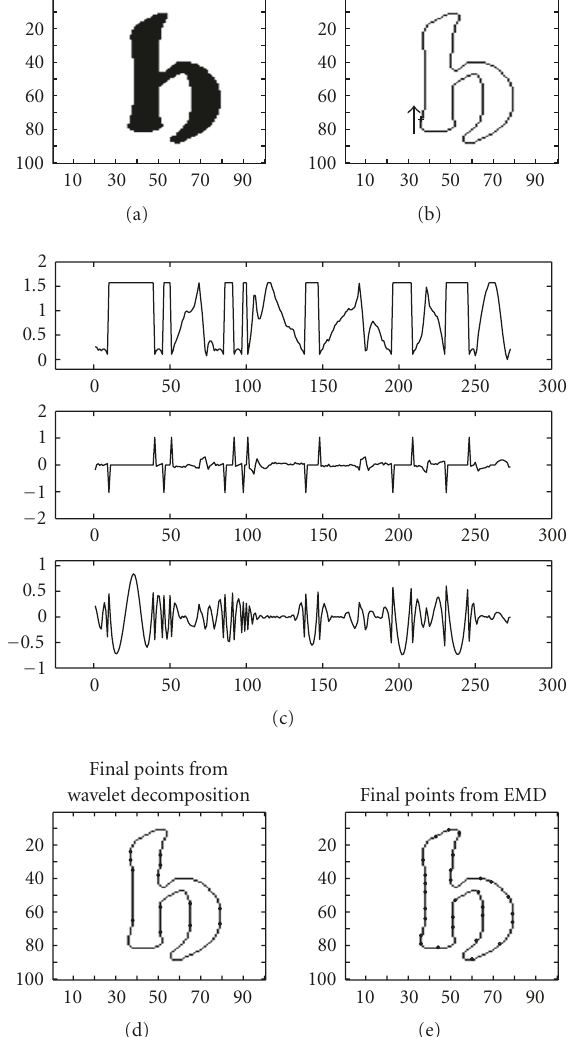
Figure 3: (a) Binary image of letter “h”; (b) starting boundary point and direction of boundary following; (c) the 1D θ − P representation of the “h”-shape object (top), haar wavelet decomposition at first decomposition level (middle), and the first IMF of the EMD (bottom); (d) feature points obtained from the location of distinct wavelet coe ffi cients; and (e) feature points obtained from the frequency content of the first IMF of the EMD.